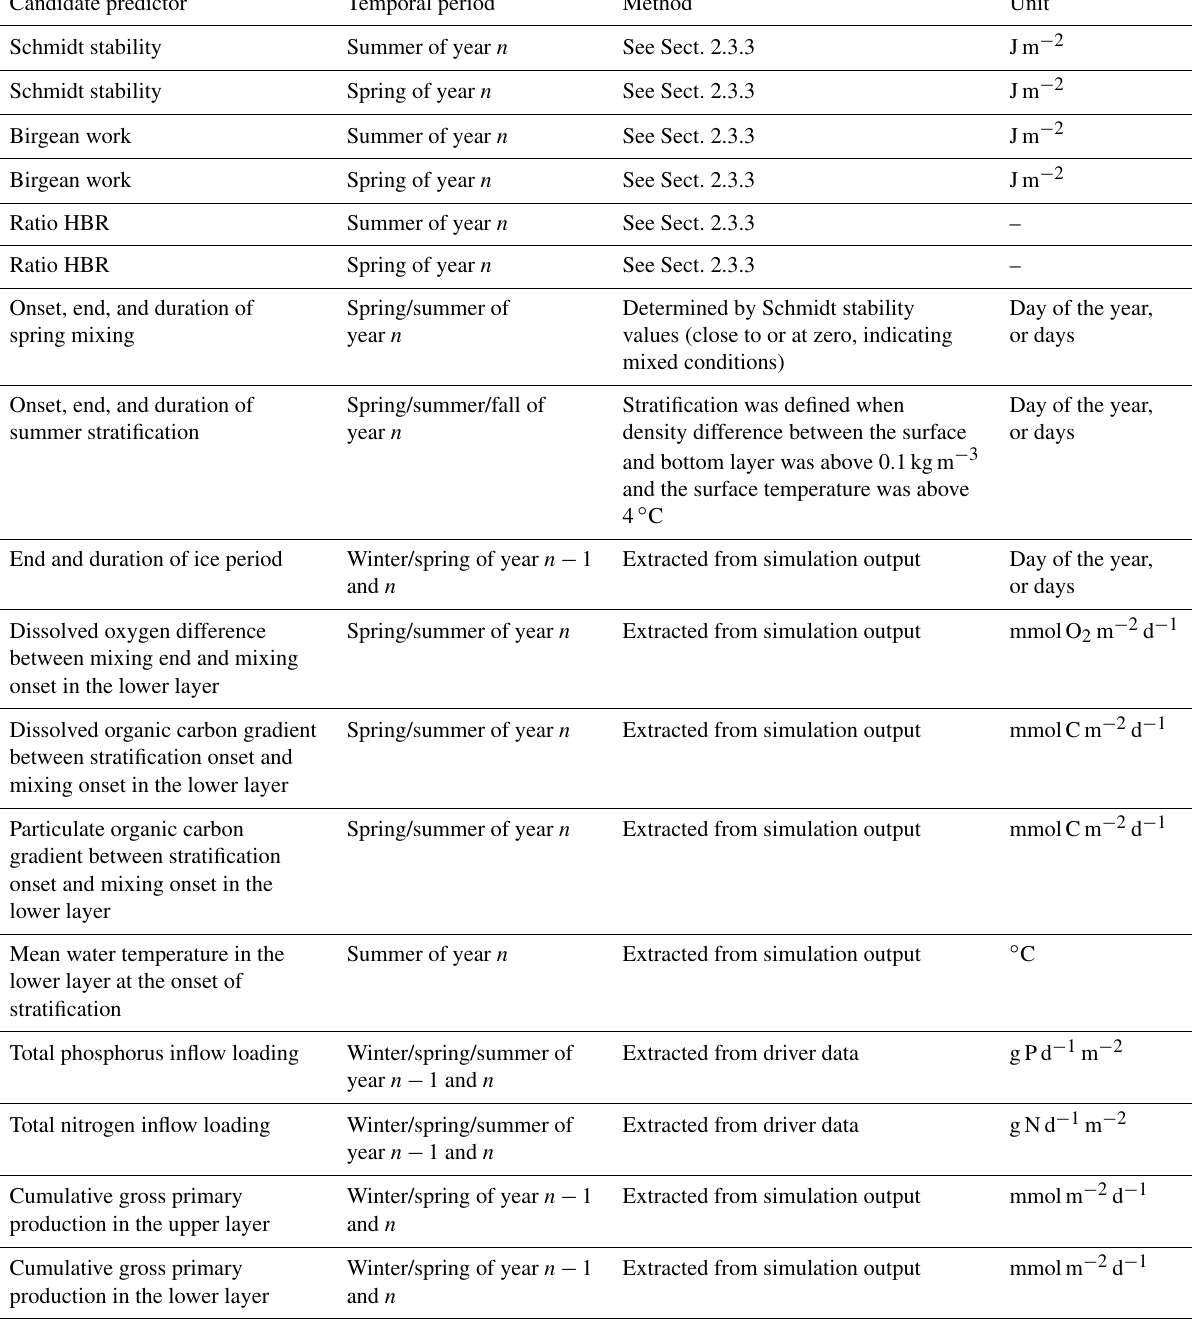
Table 1. Overview of investigated predictors in a linear regression model on estimating the anoxic factor. Candidate